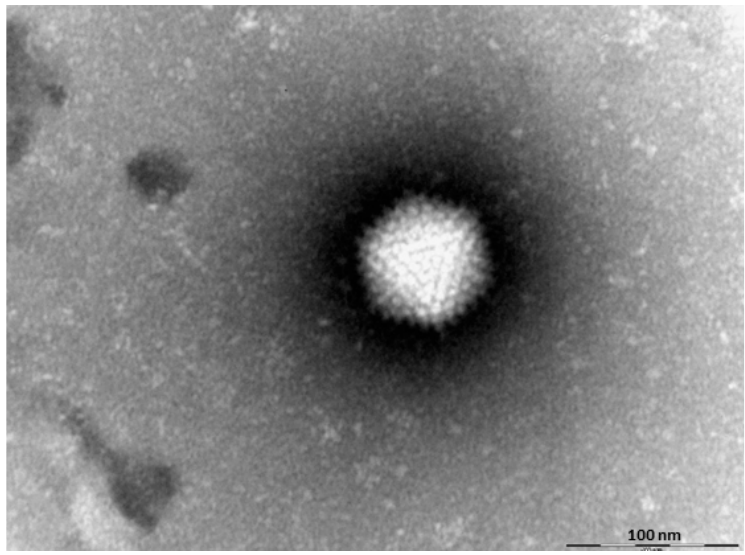
Figure 3. Adenovirus particles using electron microscopy (scale bar: 100 nm, CVUA-Stuttgart